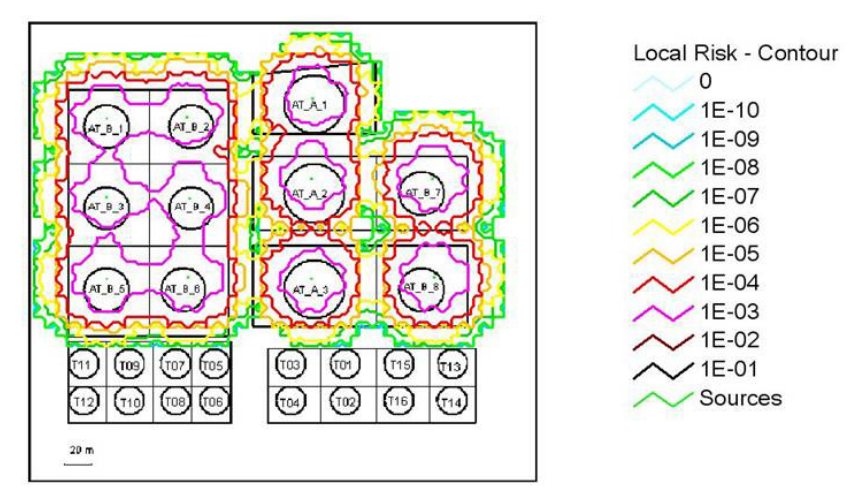
Fig. 1. Individual risk curves calculated for earthquake-induced loss-of-containment events in a storage tank farm of an oil refinery.